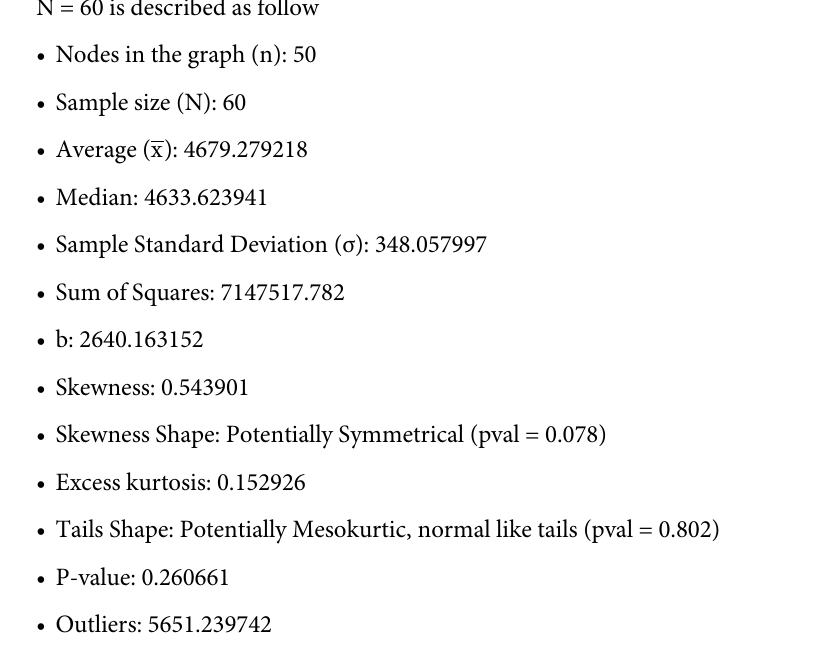
Table 12. Subset of the simulation results for 50 nodes with trial length of N = 60.